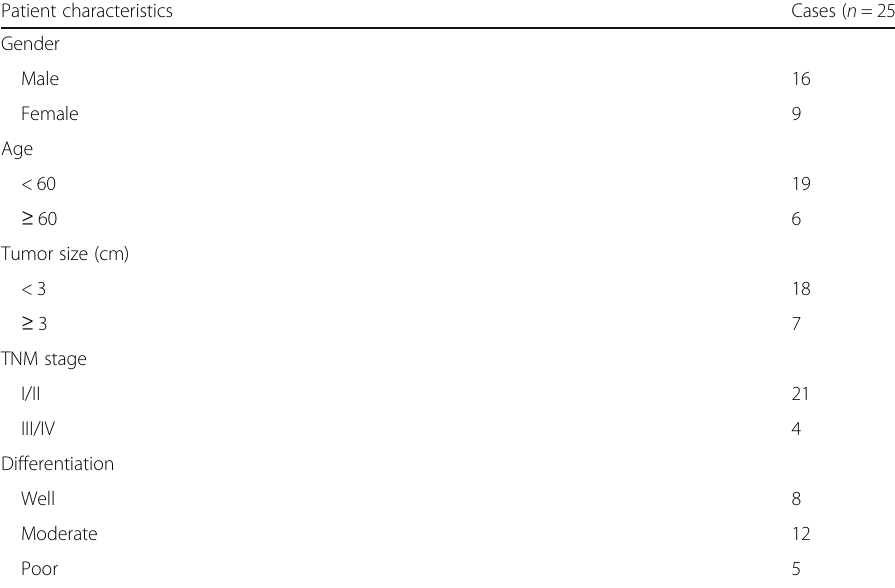
Table 1 Clinicopathological characteristics of the esophageal squamous cell carcinoma patients ( n = 25) Patient